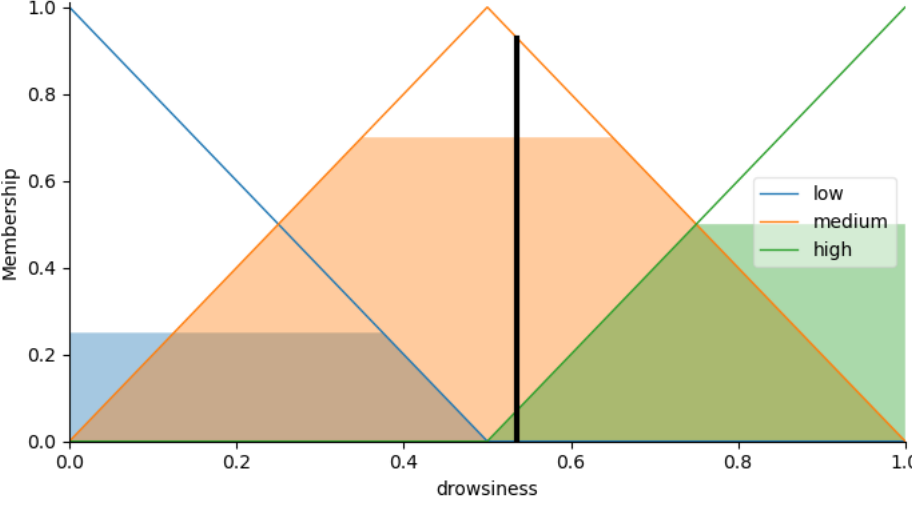
Figure 10. Defuzzification